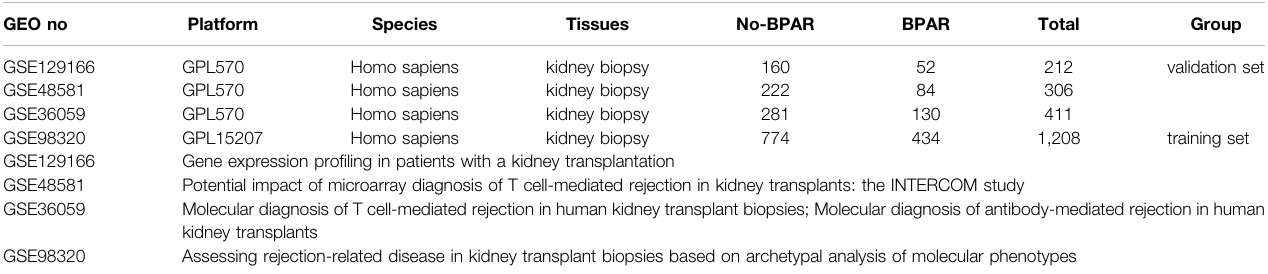
Gene expression pro fi ling in patients with a kidney transplantation